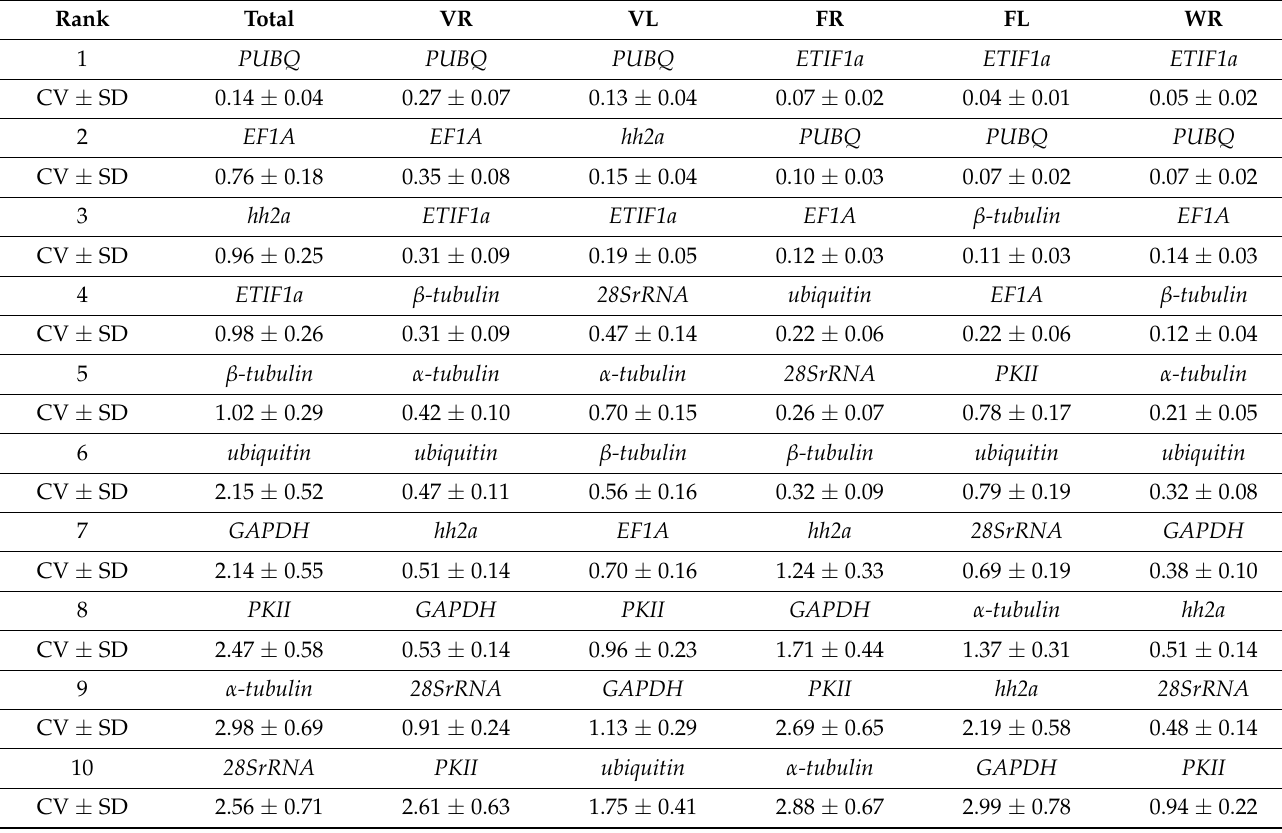
Table 3. Expression stability of the candidate reference genes calculated by the BestKeeper